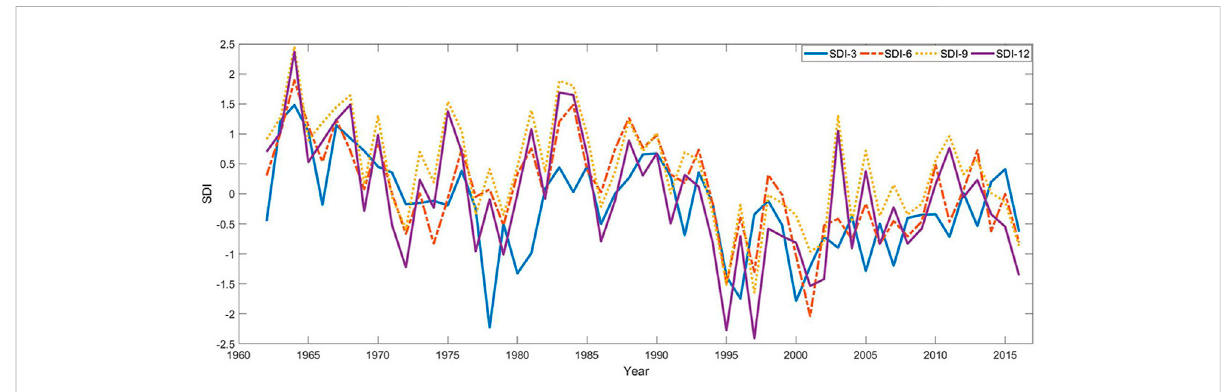
FIGURE 3 Hydrological drought on four time scales.